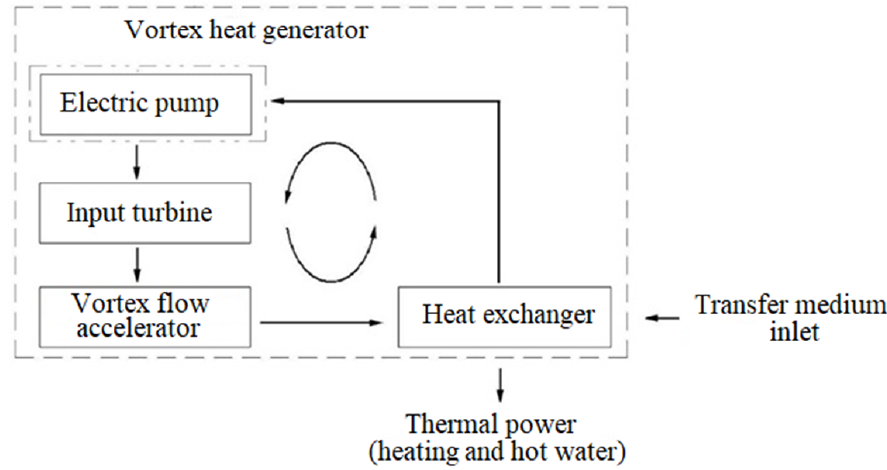
Figure 3. Basic configuration of the vortex heat generator.